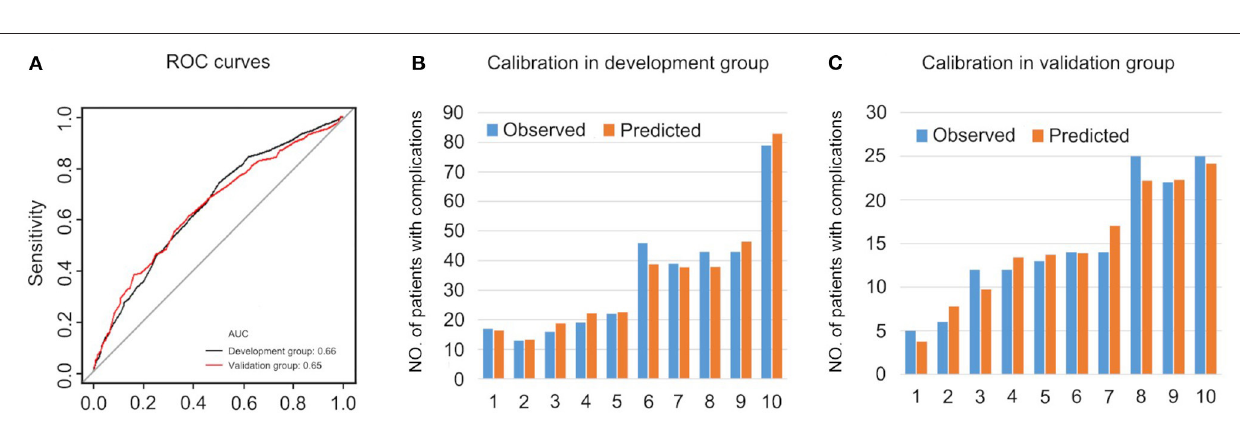
FIGURE 6 | The evaluations of the prediction model. (A) ROC curves. (B) Calibration in development group. (C) Calibration in validation